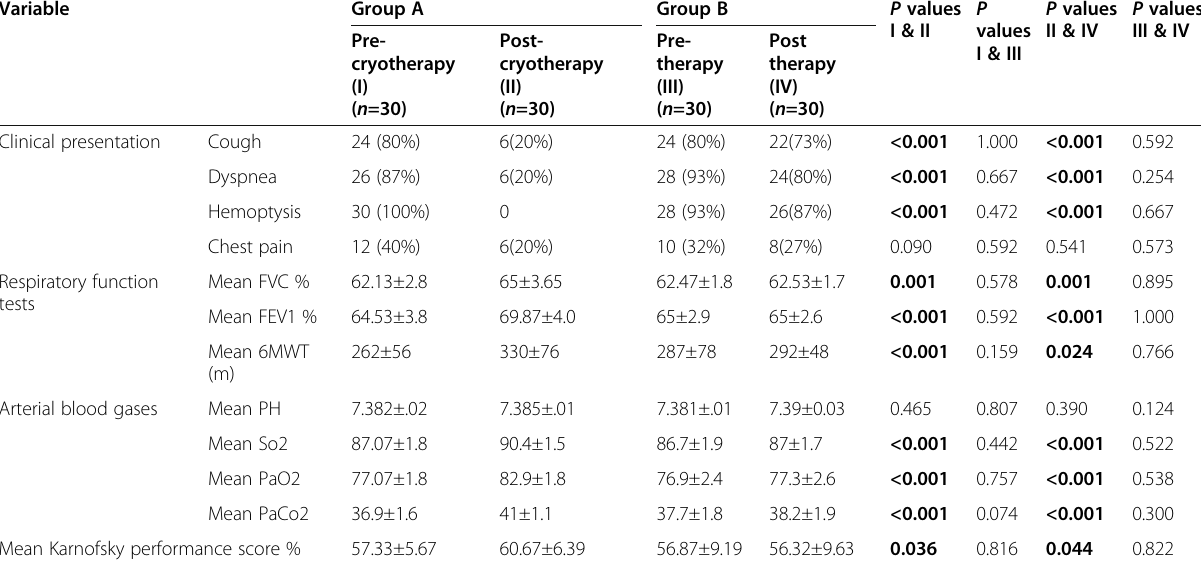
Table 2 Comparison of the clinical presentation outcomes, respiratory function tests, arterial blood gases, and the mean Karnofsky performance score for group A (EBCT+CRT) and group B (CRT) at baseline and follow-up after the procedure Variable Group